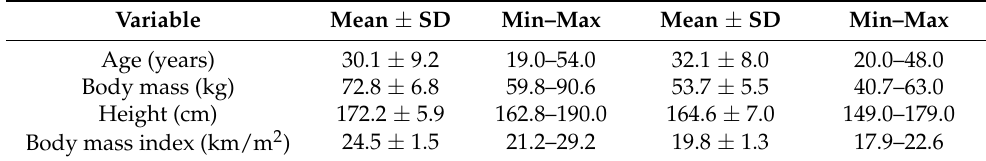
Table 1. General and anthropometric characteristics of the sample for both